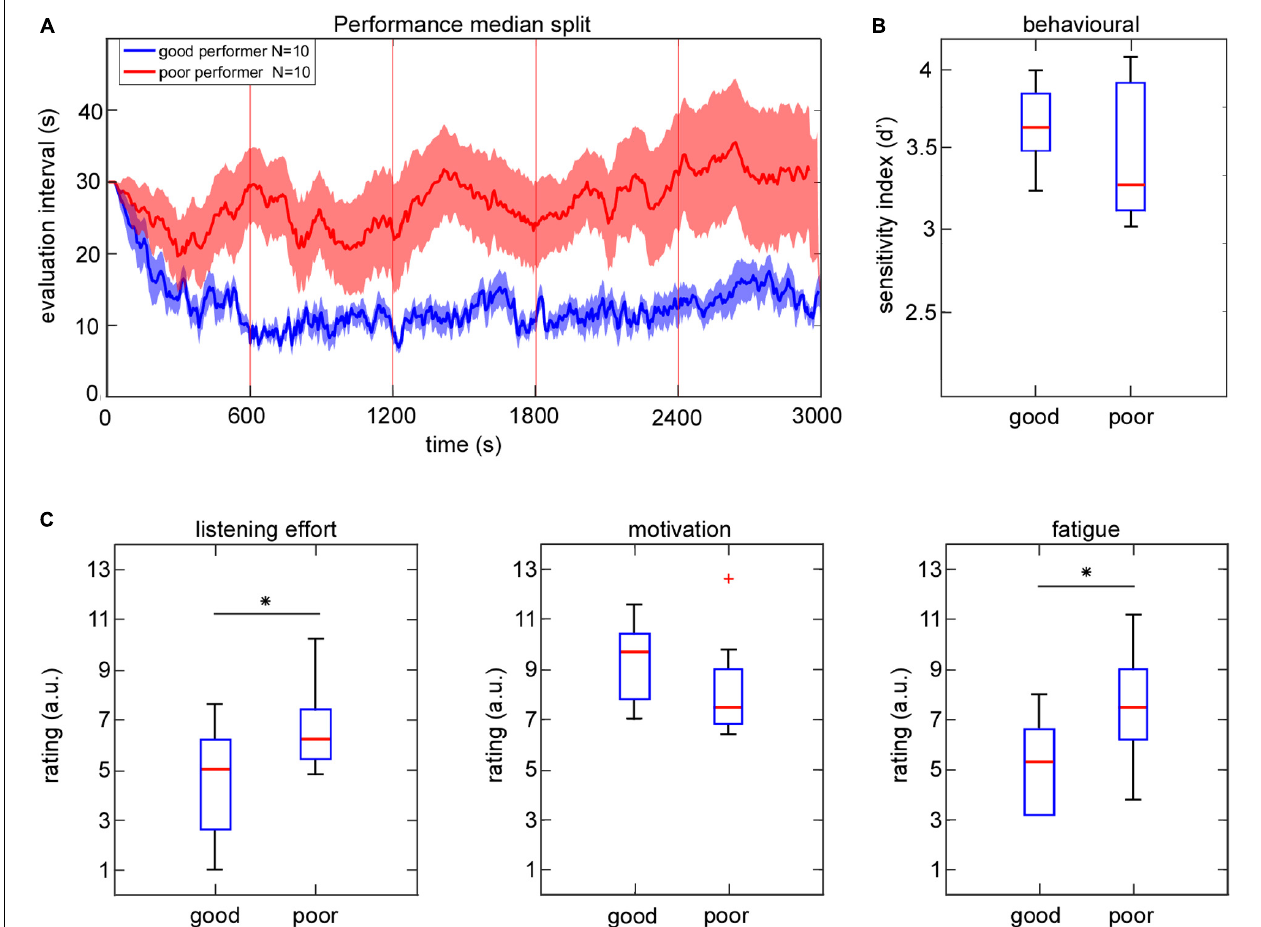
FIGURE 7 | Group median split based on attended speaker decoding performance averaged across testing blocks. (A) Group means in performance are plotted as a function of time. The shaded areas represent ± 1 SEM. (B) Box plot contains the behavioral sensitivity index for good and poor performer. (C) Box plots contain subjective ratings of listening effort, motivation and fatigue averaged across all testing blocks for the good and poor performer. Asterisks mark a significant difference in mean subjective ratings between groups (Mann–Whitney U -test, p <